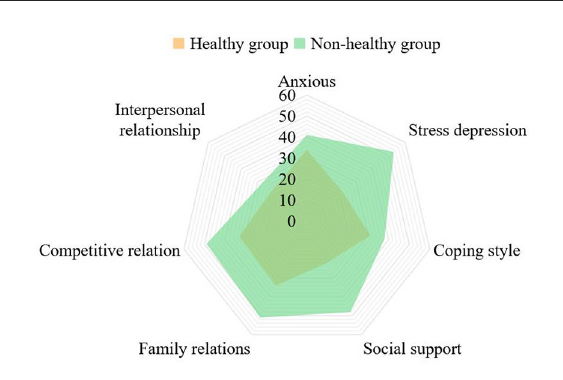
FIGURE8 Comparison of characteristic scores between healthy group and non-healthy